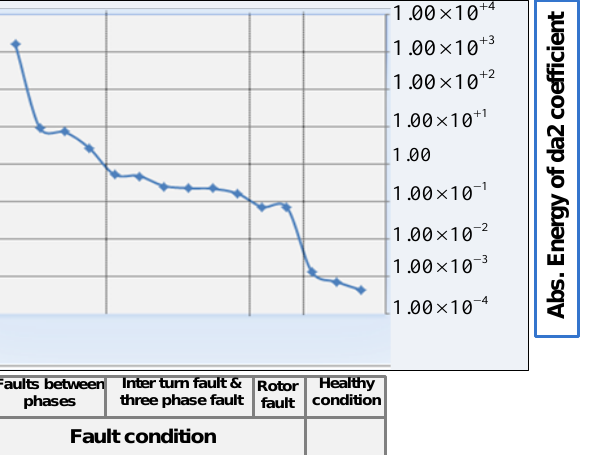
Figure 16. Entropy Energy (EE) value for different operation condition of an induction motor using da2 WPT subband coefficients.